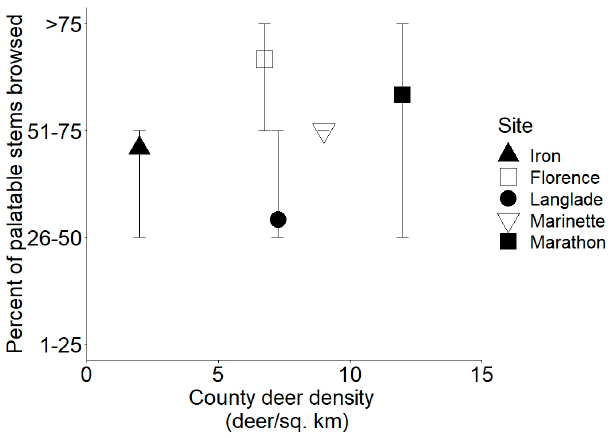
Figure 4. Estimated county-level deer density at each site [27] versus mean percent of palatable stems browsed at each site. Error bars indicate range of browse level across all plots in each site.